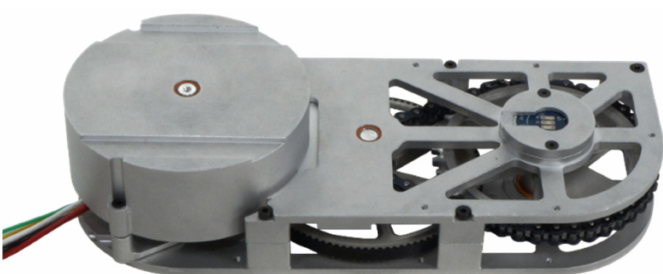
Figure 2. Picture of joint actuator for the pediatric exoskeleton configured for free-spinning without an actuator arm.